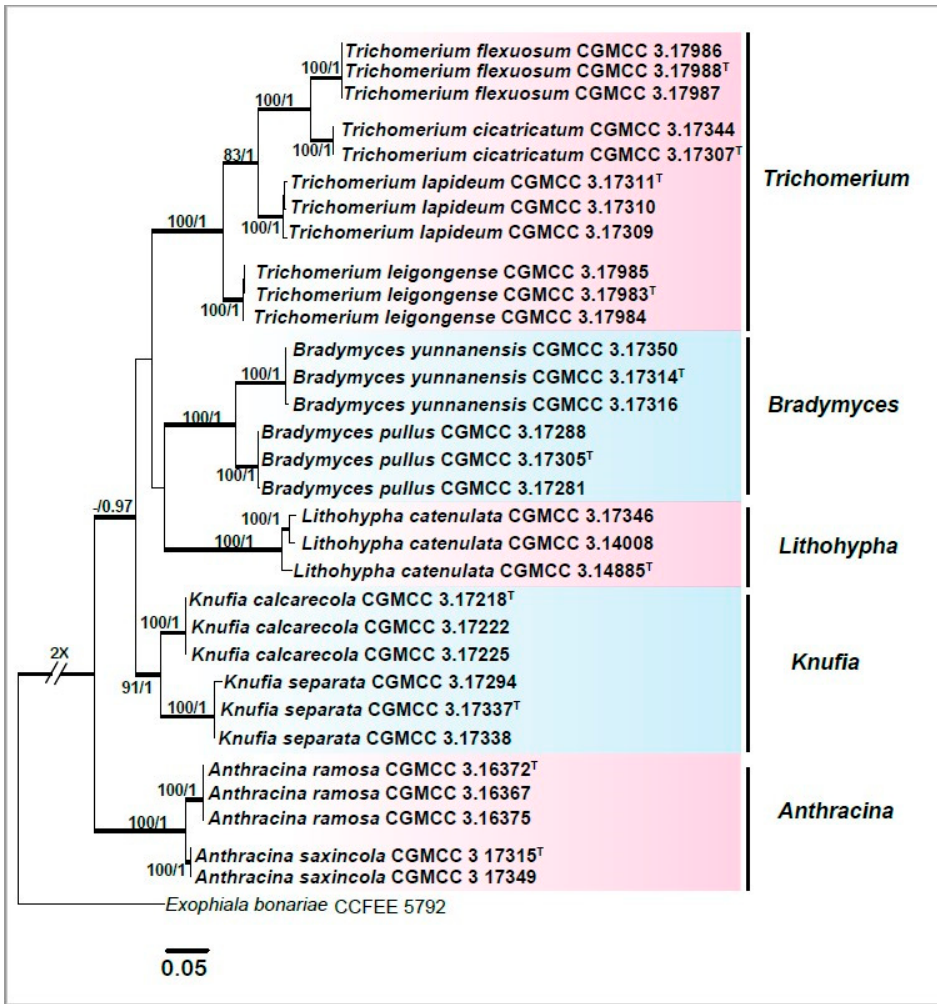
Figure 3. Phylogenetic tree generated by the maximum likelihood analysis using combined sequences of ITS, nucLSU, mitochondrial small subunit ribosomal DNA (mtSSU), the largest subunit of RNA polymerase II (RPB1), and the partial β -tubulin gene (TUB) loci of the family Trichomeriaceae. Bootstrap values ≥ 70% ( left ) and Bayesian posterior probability values ≥ 0.95 ( right ) are indicated at nodes (ML / BI). Thickened branches represent posterior probabilities ( > 0.95) from BI. Novel sequences generated in this study are indicated in bold. Exophiala bonariae strain CCFEE 5792 is used as the outgroup. Ex-type cultures are marked with “ T ”.